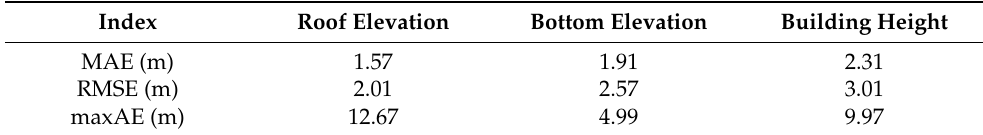
Table 2. Accuracy statistic of building height estimation.